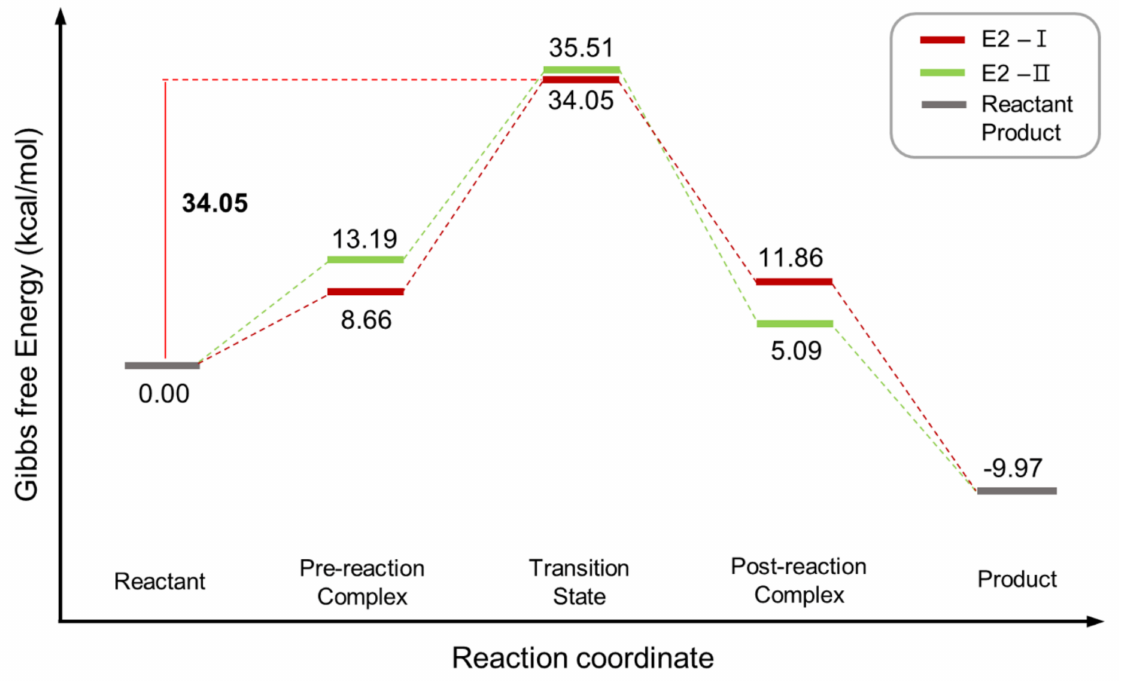
Figure 4. Calculated energetics of the E2 elimination of 1 in CH 3